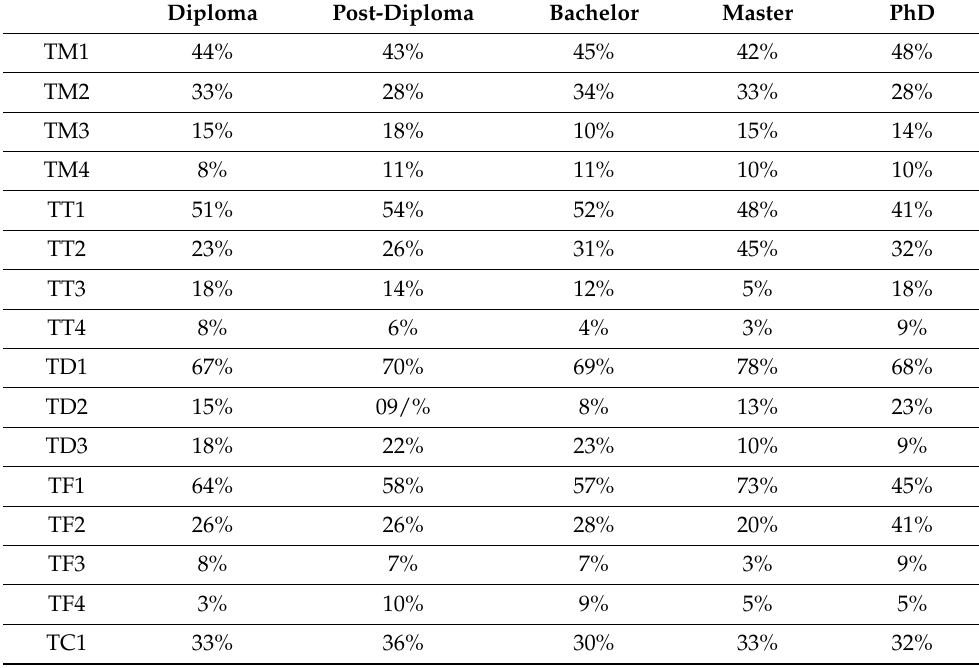
Table 7. Priorities of TBCs from the lens of educational